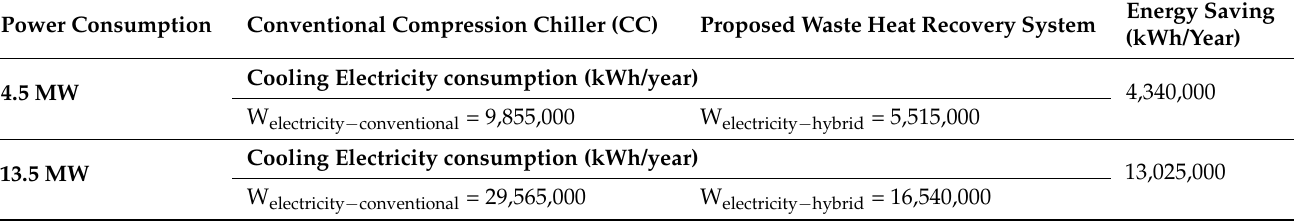
Table 1. Energy analysis for cooling a 4.5 MW and 13.5 MW data center comprising 300 and 900 racks with chillers of 575 ton and 1600 ton